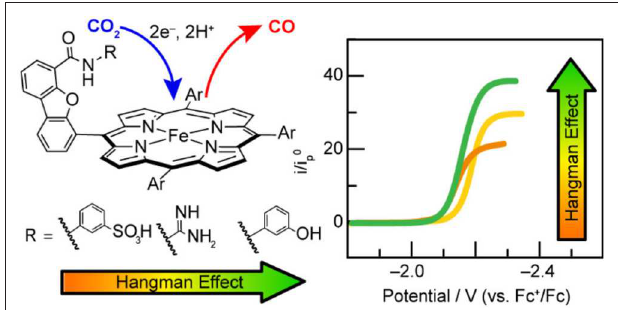
FIGURE 6 | Figure showing effect of p K a of the hanging group on CO 2 reduction activity in hangman [Fe(TPP)] + . Reprinted with permission from Margarit et al. (2018). Copyright 2018 American Chemical